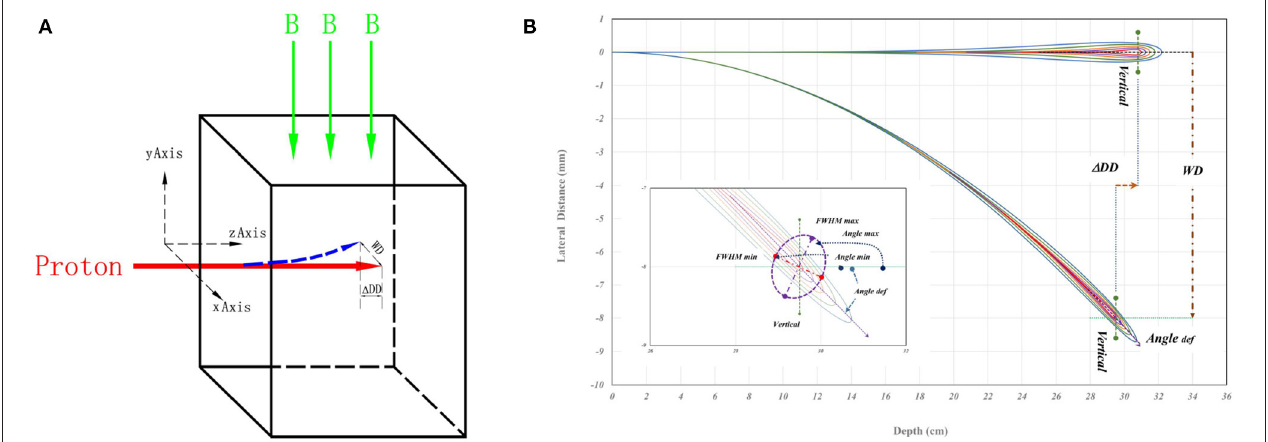
FIGURE 1 | (A) A schematic drawing of simulation geometry with indicated directions of beam entrance and magnetic field. The proton beam vertically enters the water phantom from left to right, and the red arrow represents the beam. The green arrow is the direction of the magnetic field. (B) A schematic drawing for proton dose distributions as a straight path without magnetic field, and as a spiral track under the influence of magnetic field in a cut plane over the directions of beam entrance and the magnetic field. The WD and 1 DD were the shift of Bragg-peak position. The “ Angle def ” is the deflection angle of spiral track beam central axis the. In the insert of (B) , the maximum and minimum of the full width at half maximum (FWHM) and the major and minor axes of elliptical 2D distribution at the Bragg-peak location. The Angle max and Angle min are the angles of maximum and minimum full-width-half-maximum in the major and minor axes of doses passing the location of Bragg-peak. Details are in the